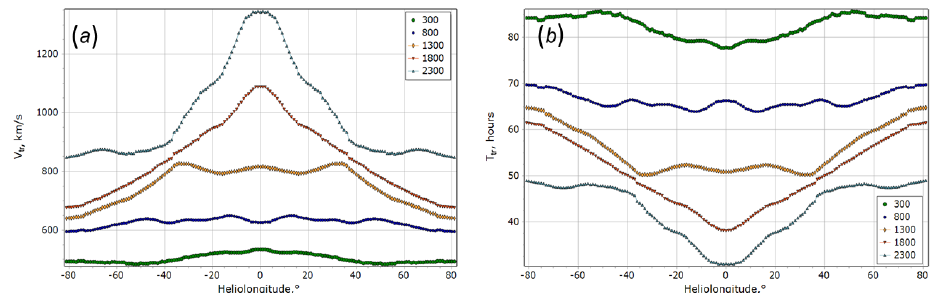
Figure 7. Dependencies of the expected transit velocities [ V tr ] ( a ) and time of arrival ToA [ T tr ] ( b ) on the initial CME speed and longitude of the associated flare.